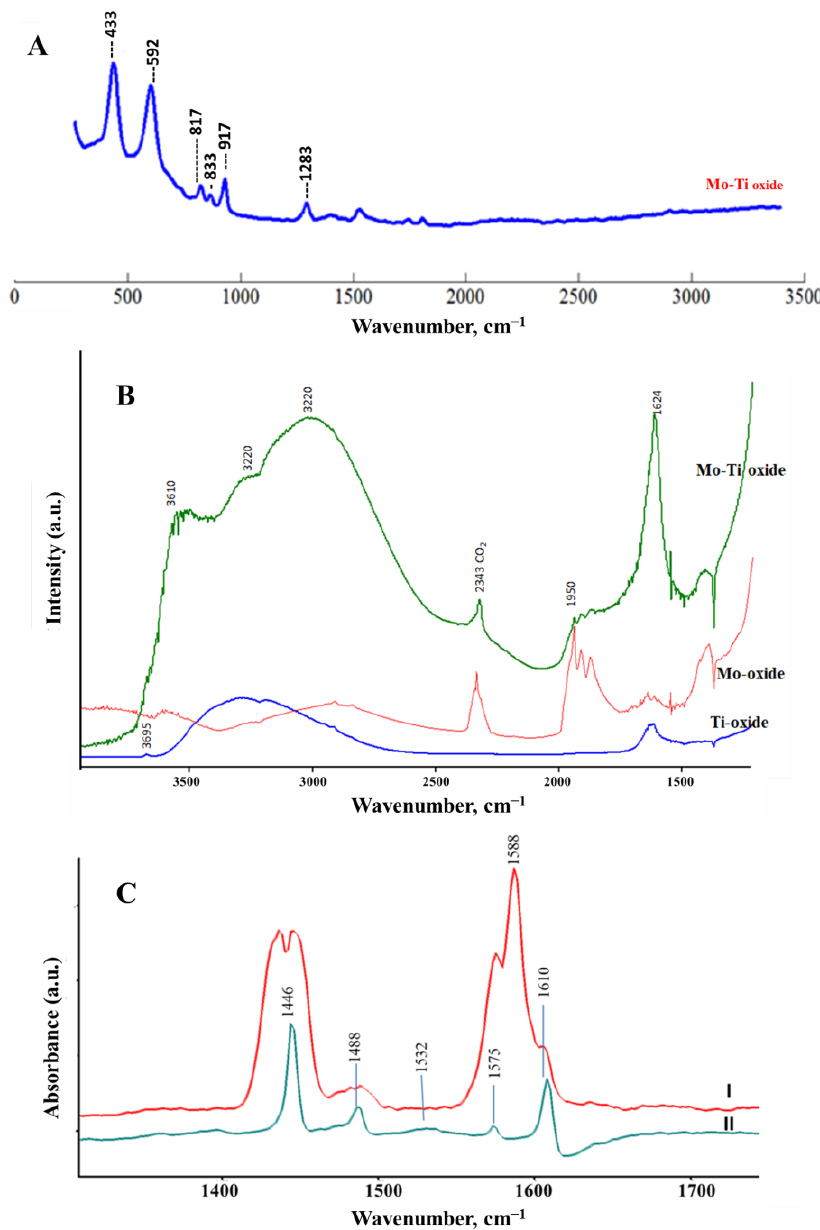
Figure 5. Surface analyses for Ti-Mo NC: ( A ) Raman spectroscopy, ( B ) DRIFT spectroscopy, and ( C ) FTIR spectroscopy for thin film surface exposed to pyridine vapor (I) followed by evacuation for 2 min (II).